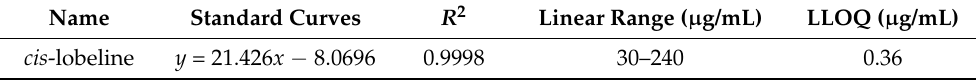
Table 3. Standard curves, correlation coefficients, linear range, and LLOQ of cis